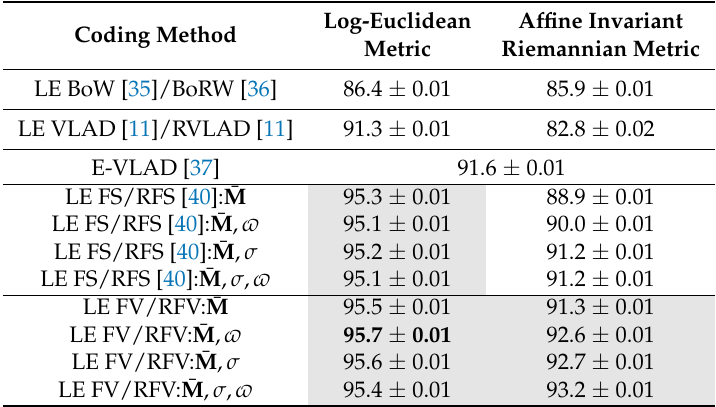
Table 3. Classification results on the VisTex database (40 classes).